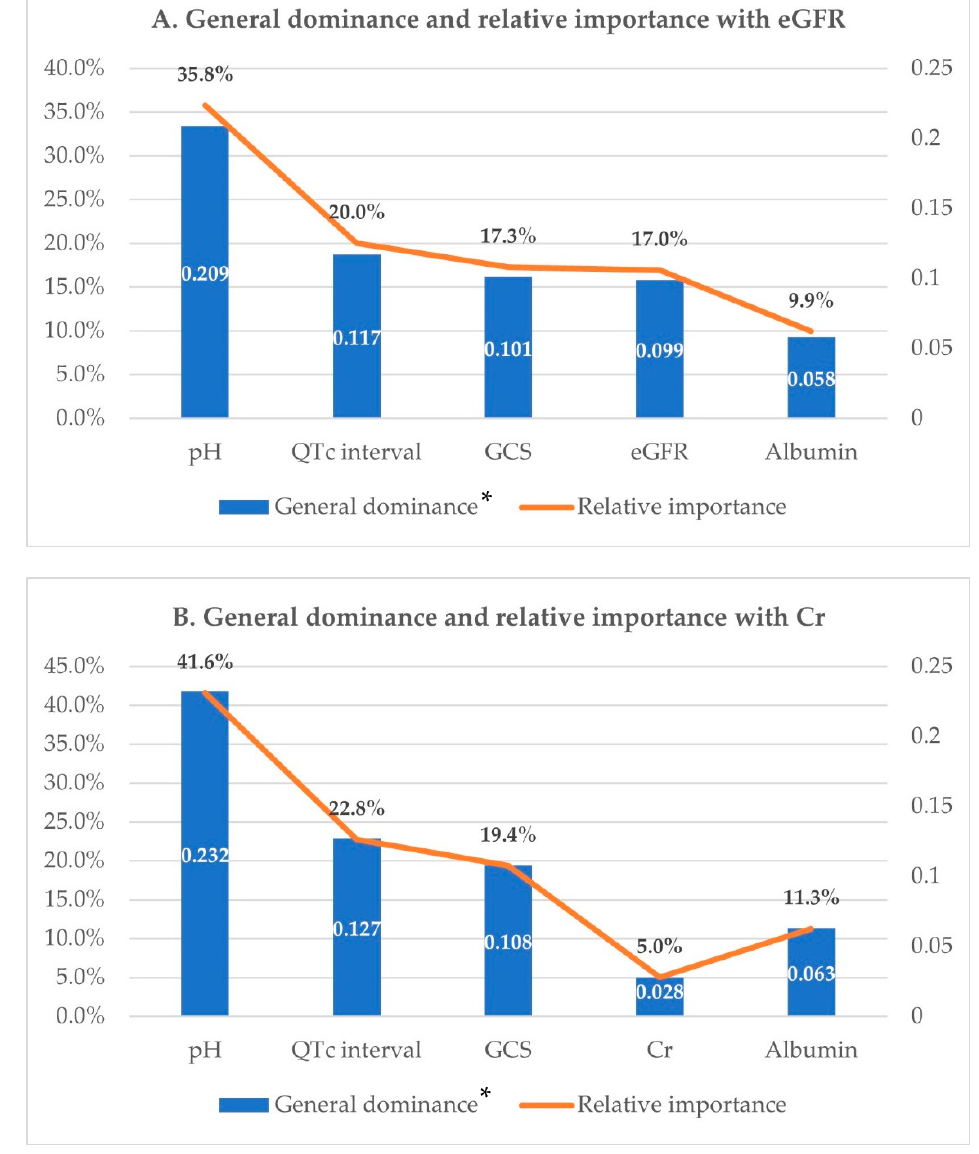
Figure 3. Dominance analysis. General dominance and relative importance of independent factors for predicting in-hospital mortality. GCS: Glasgow Coma Scale; QTc interval: corrected QT interval; eGFR: estimated glomerular filtration rate; Cr: creatinine. * Calculated by summing the conditional dominance statistics for each predictor.